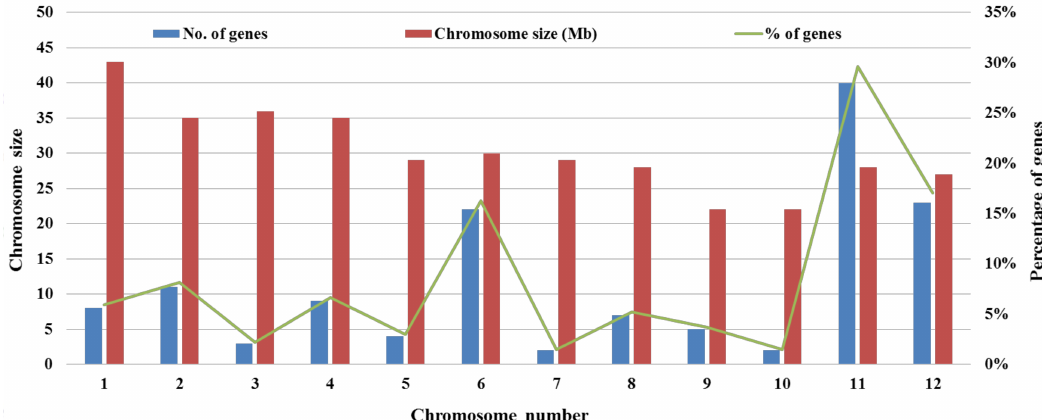
Figure 2. Chromosome-wise distribution of major resistance genes identified from rice. Numbers 1–12 represent the chromosome of rice. Percentage of resistance gene sharing on each chromosome is shown in green solid line, while blue and red bars represent number of resistance genes on each chromosome and chromosome size (Mb),